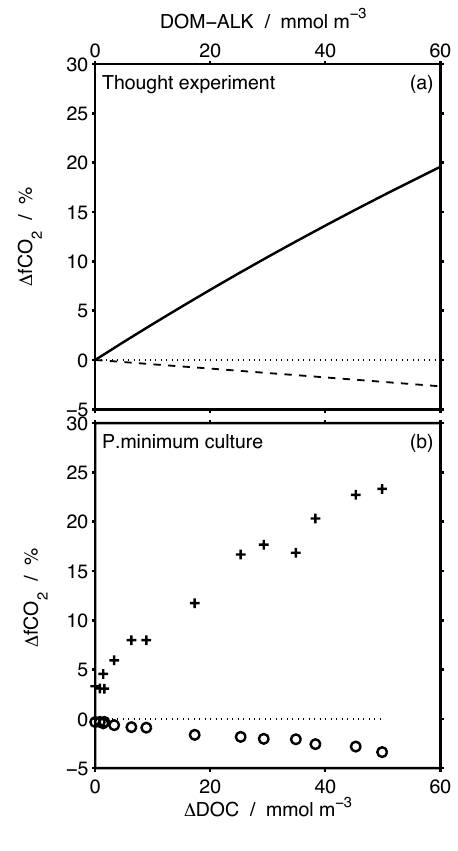
Fig. 5. 1f CO 2 (A (solid line, +), 1f CO 2 (A (dashed line, T ,C T ) T , pH ) o), and 1f CO 2 (C (dotted lines) from (a) a thought experiment T , pH ) and numerical simulations (for details see Sect. 3.2) and (b) the P. minimum culture. X-axes is either the potential DOM-alkalinity (µmolkg − 1 ) assumed in the numerical simulations (a) or (b) the measured DOC accumulation over the experiment (µmoll − 1 ).